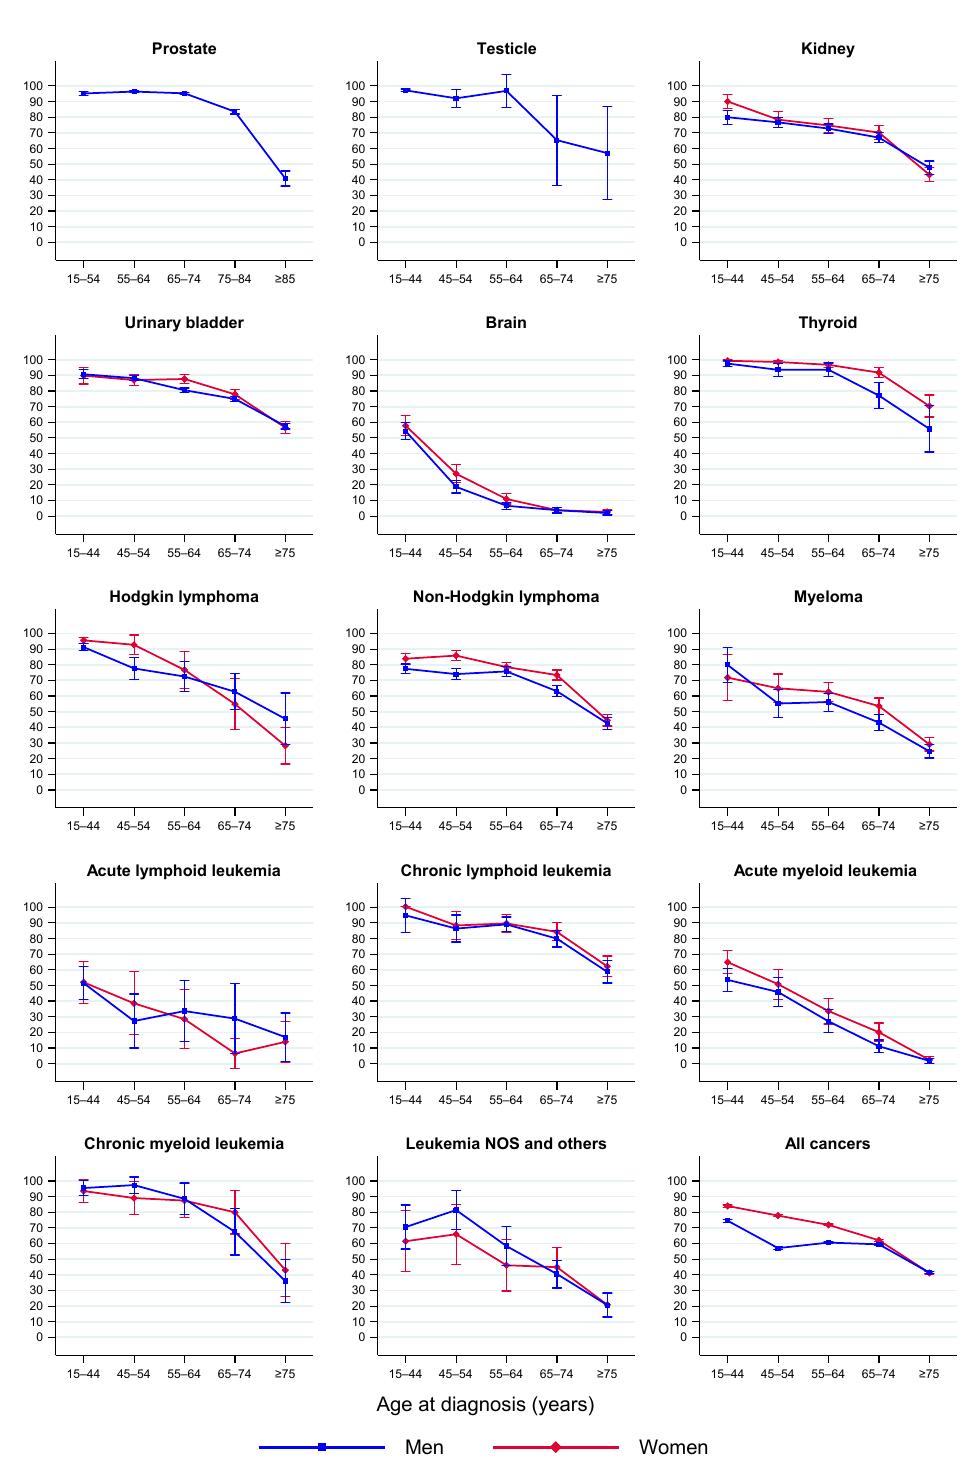
Figure 1. Five-year net survival by age group and sex in adult patients diagnosed with cancer in Spain in 2008–2013. Error bars are 95% CIs. The “all cancers” category excludes non-melanoma skin cancer. Abbreviations: NOS, not otherwise specified.